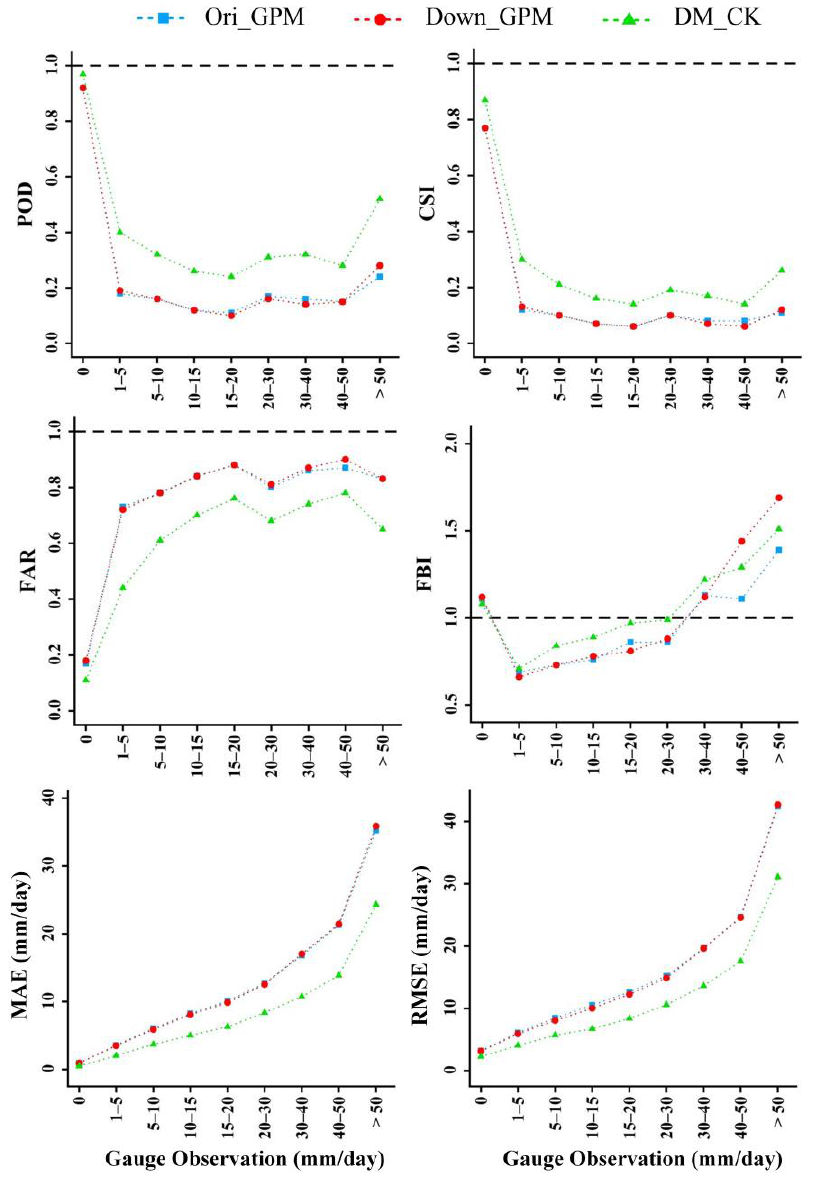
Figure 8. Evaluation for qualitative indices and quantitative indices of the Ori_GPM, Down_GPM, and DM_CK for daily precipitation estimates in various precipitation intensity from March 2016 to February 2018.